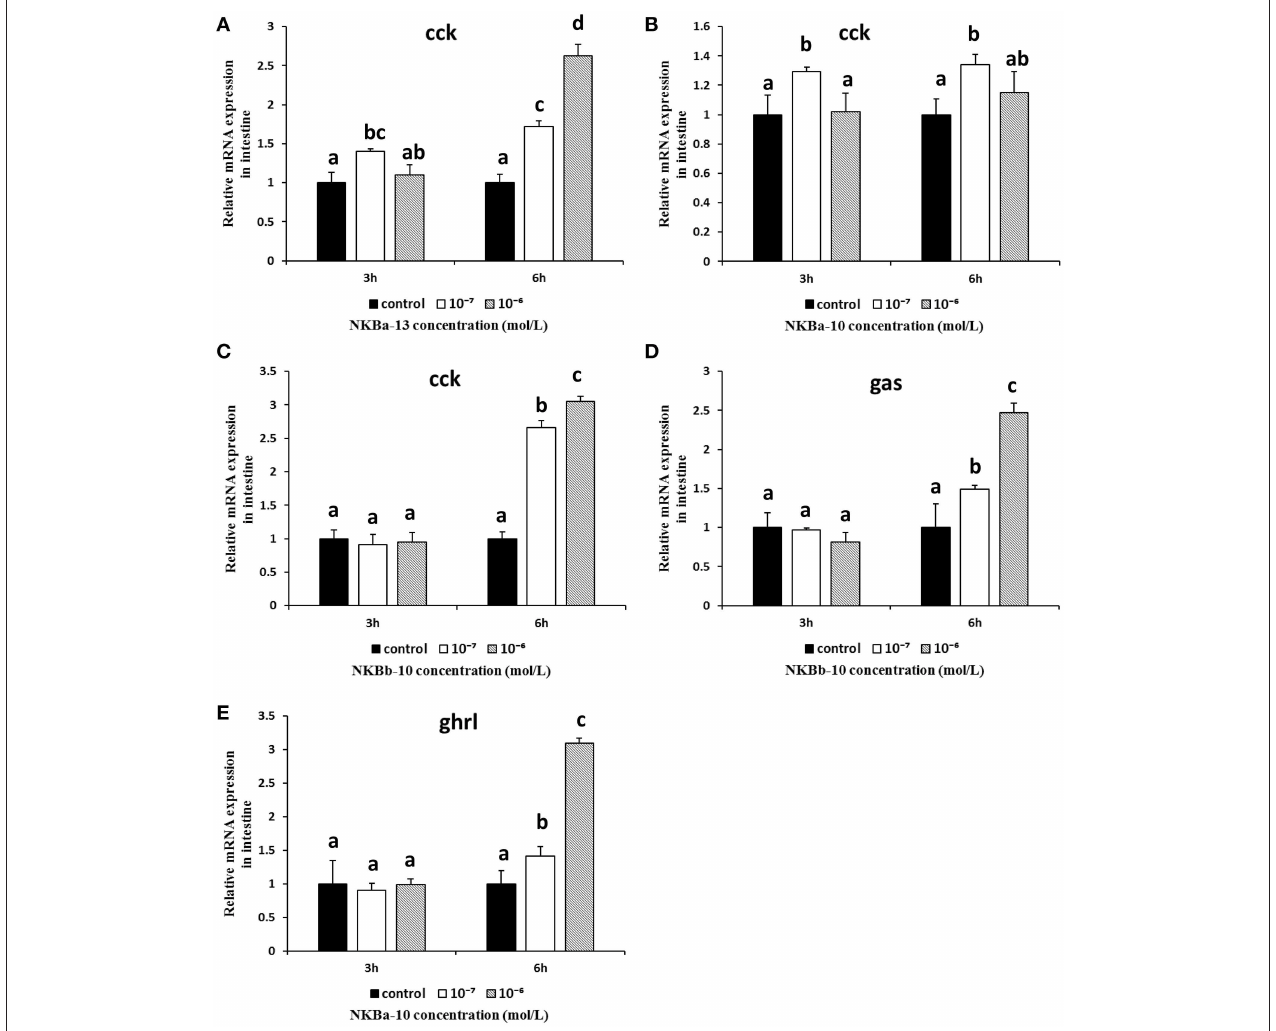
FIGURE 13 | Effect of NKBs on the expression of brain-gut peptide (BGP)-related genes in the intestine. (A–C) Effect of NKBa-13, NKBa-10, and NKBb-10 on the mRNA levels of cck in the intestine. The X axis indicates hours after NKB treatment. (D) Effect of NKBb-10 on the mRNA levels of gas in the intestine. (E) Effect of NKBa-10 on the mRNA levels of ghrl in the intestine. The results are represented as the mean ± SEM and expressed as fold of the expression level in controls. Significant differences are noted by different letters for each concentration ( P <